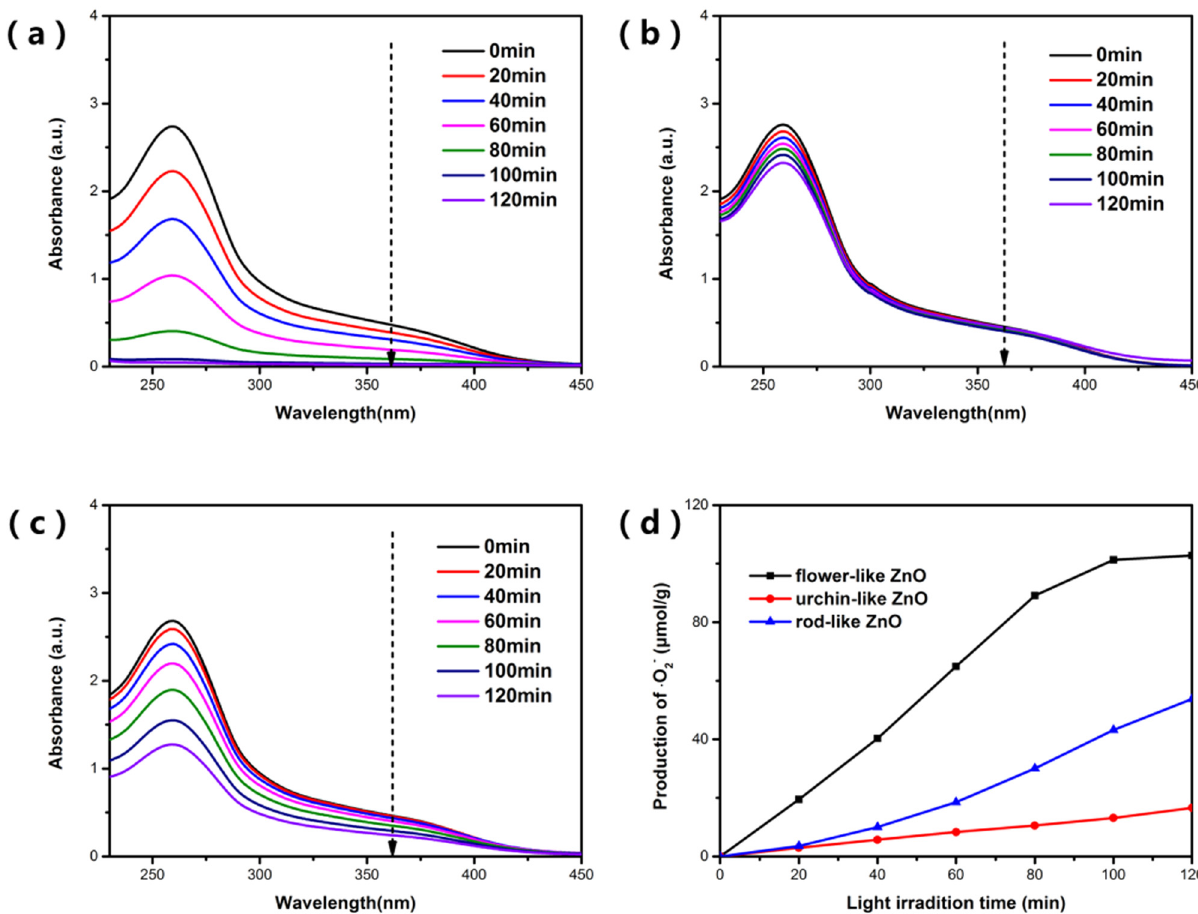
Figure 10: UV - Vis absorption spectra of NBT degraded by ZnO with three morphologies of ( a – c ) fl ower - like ZnO, urchin - like ZnO, and rod - like ZnO, and ( d ) the yield of ˙ O 2− in ZnO suspension under simulated sunlight with